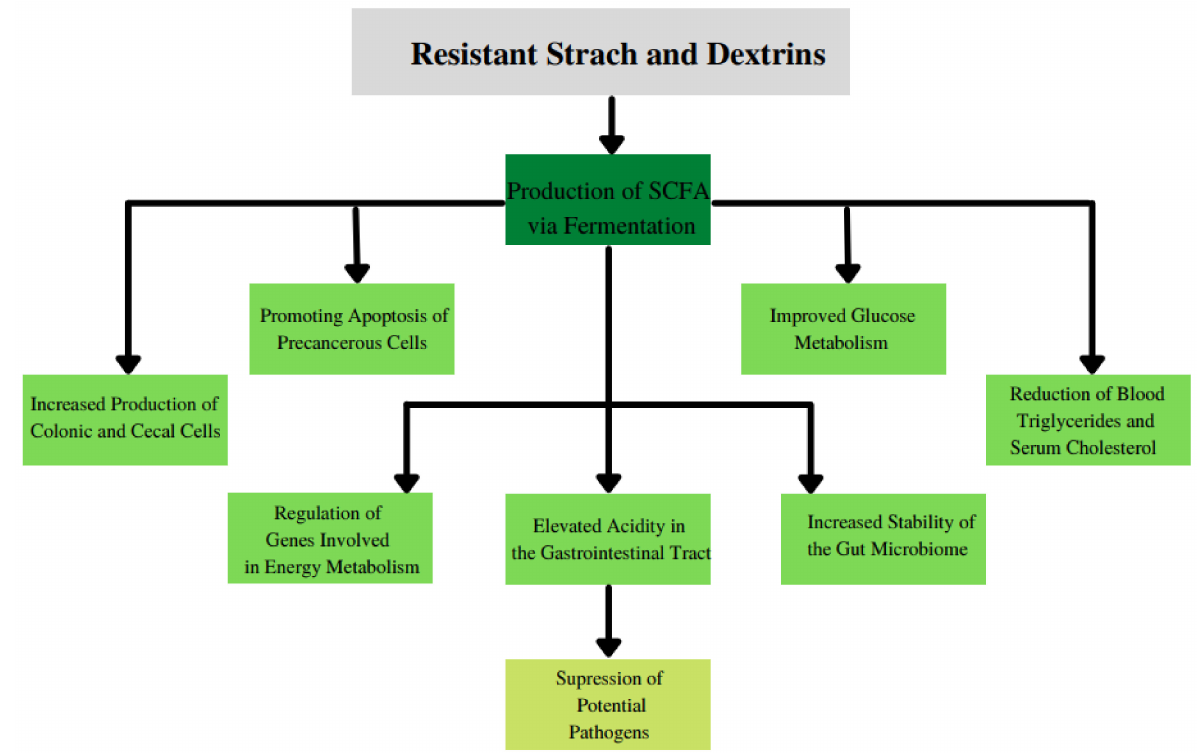
Figure 4. The main benefits of consumption of resistant starch and